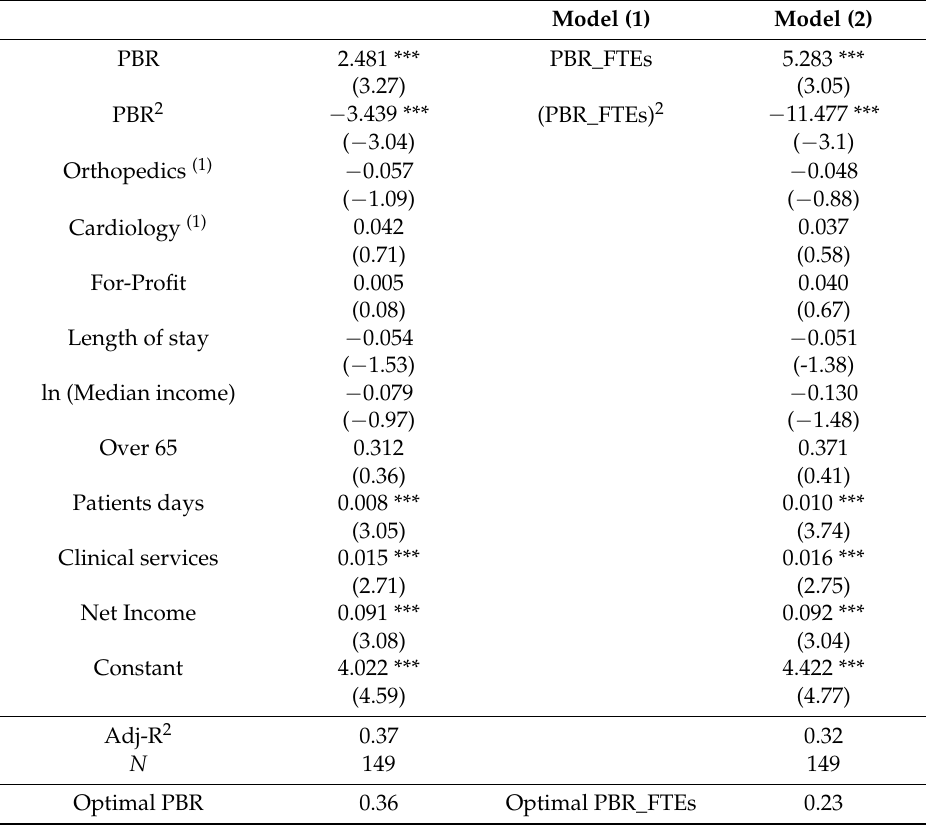
Table 2. IV–GMM regression. Dependent variable: Ln ( IHQ ), endogenous variable: